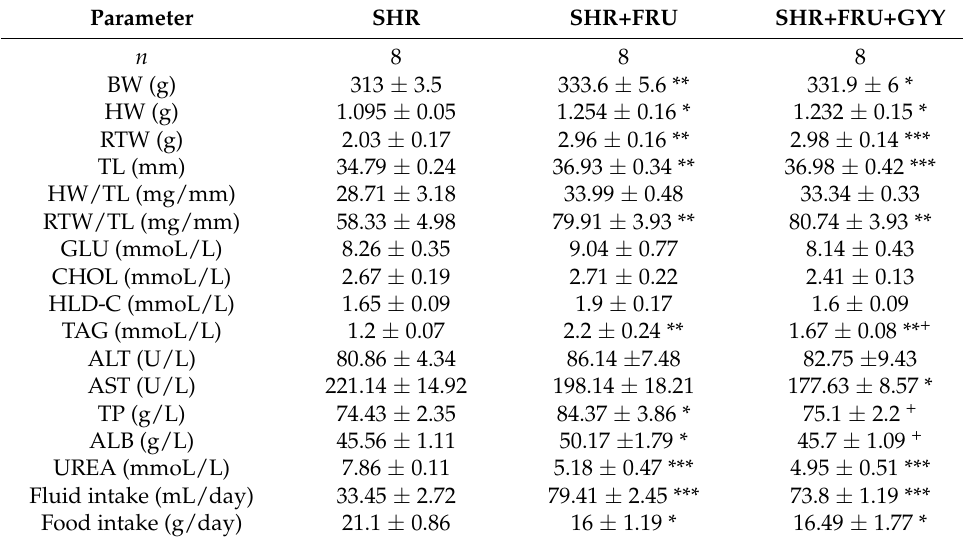
Table 1. General characteristics of experimental